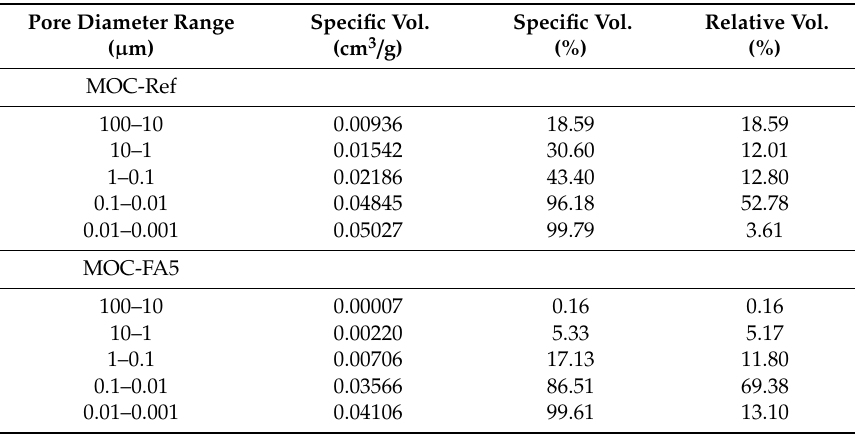
Figure 5. Cumulative pore volume curves. Table 6. Distribution of pore volume.